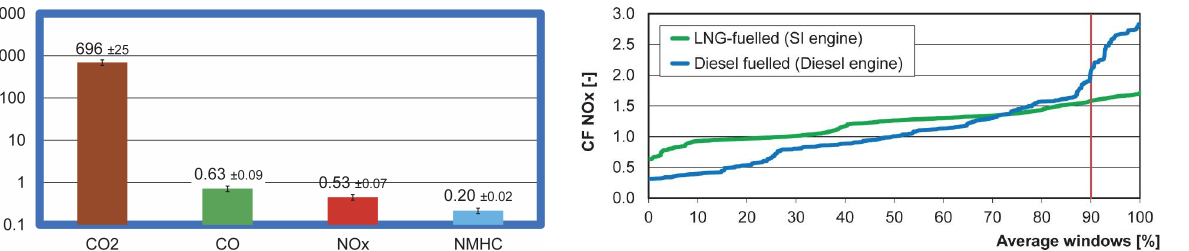
Figure 8: Conformity factor for specific nitrogen oxides emissions for the two tested buses.